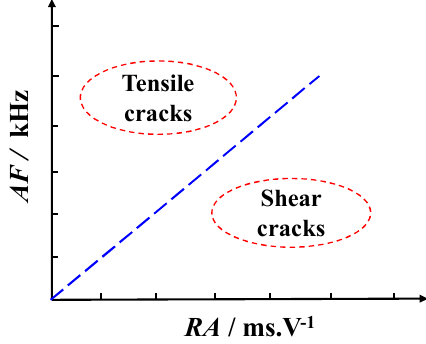
Figure 8. Crack classification based on AF–RA correlation analysis.